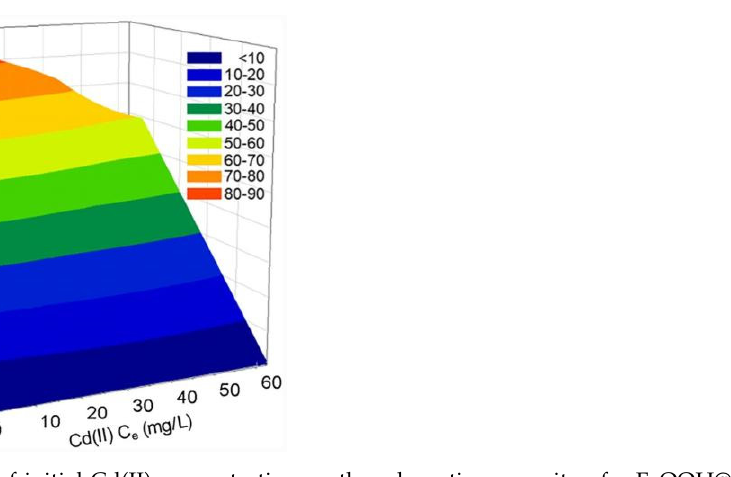
Figure 23. Effects of different cations on the adsorption of 25 mg/L As(V) at 298 K [96]. Reprinted with permission from Fanqing Meng et al. (2017). Copyright 2017 American Chemical Society.